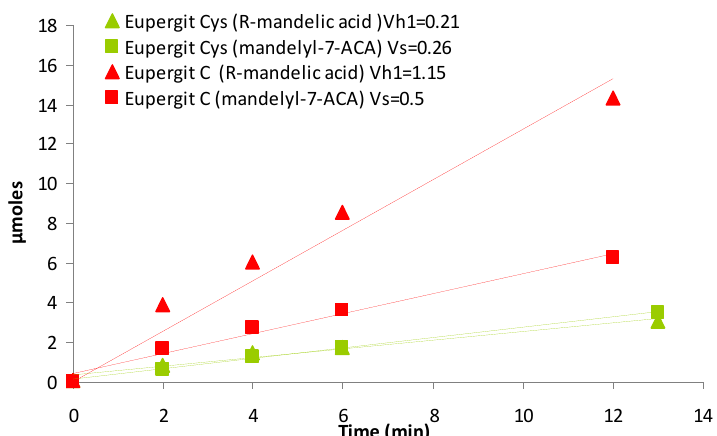
Figure 5. Vs (square) and vh (triangle) of the reaction catalyzed by PGA immobilized on 1 Eupergit ® C before (red) and after quenching with 1.5 M cysteine (green).